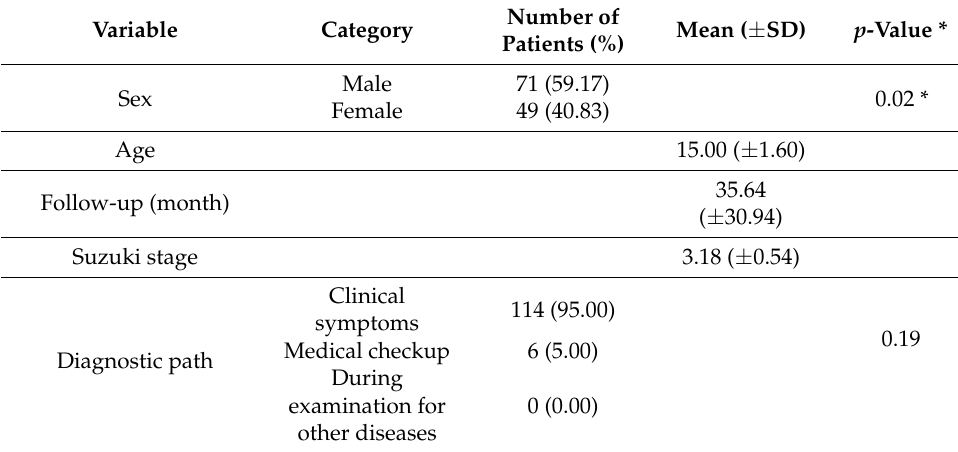
Table 1. Characteristics of participants ( n =